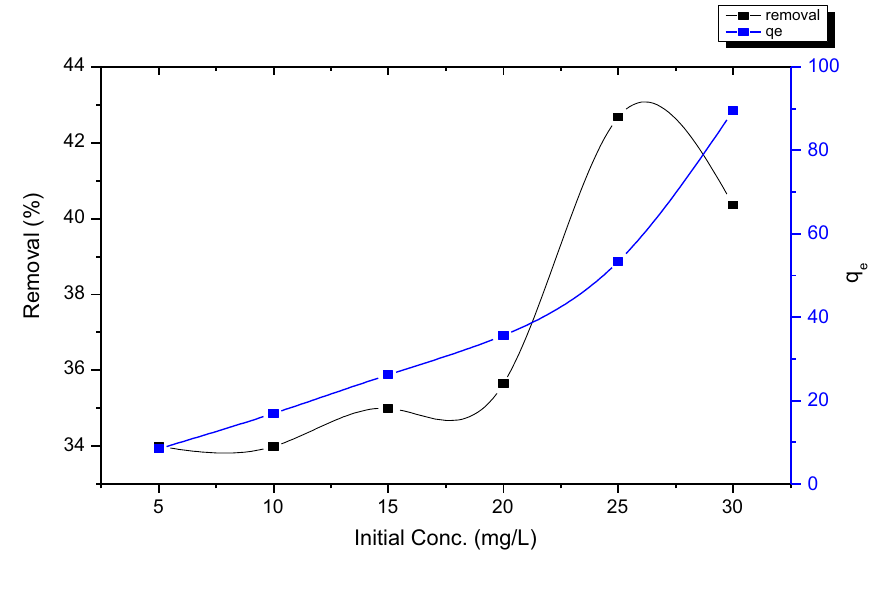
Fig. 5 Effect of initial concen- tration